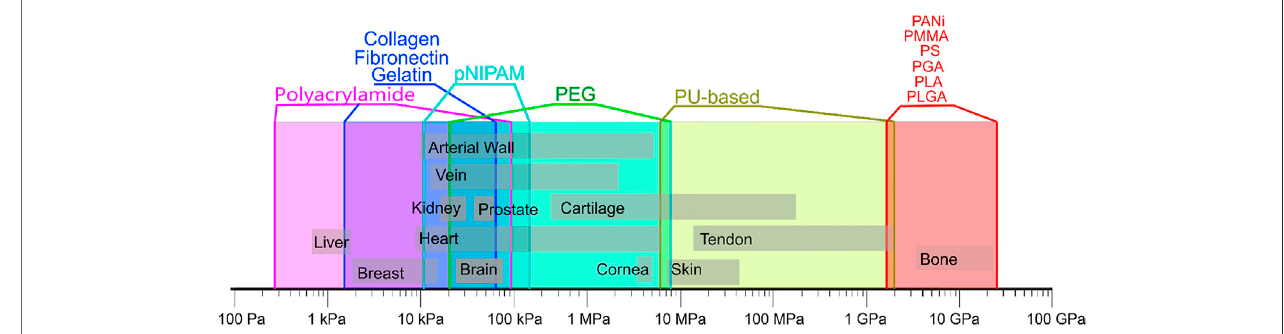
FIGURE2| Mechanicalpropertiesofnaturaltissuesandpolymers.Dataarecomposedbasedondatafromthefollowingpublications (NemirandWest,2010;Kim et al., 2012; Saveleva et al., 2019). Reprinted (adapted) with permission from (Abalymov et al.,